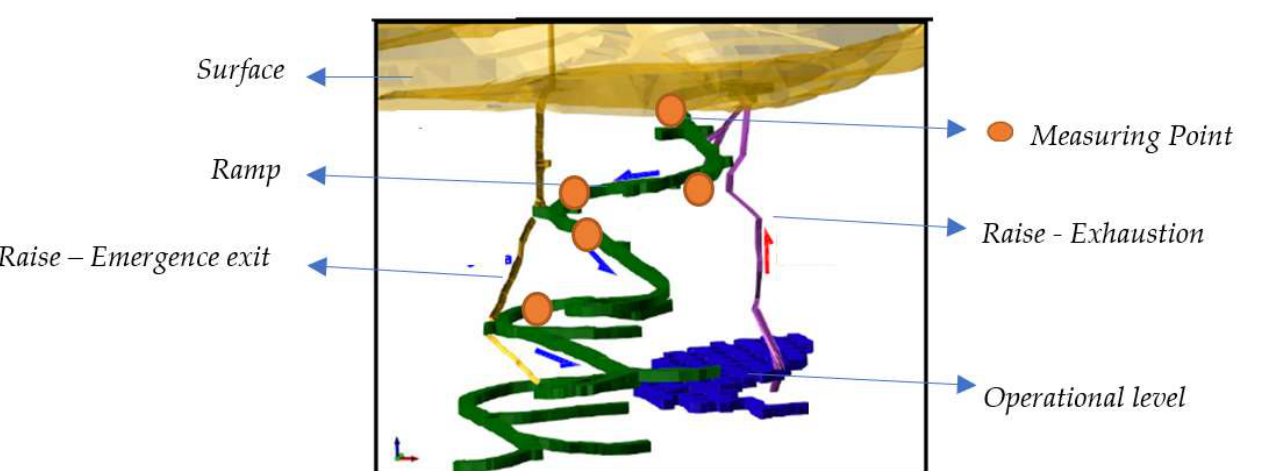
Figure 2. 3D underground mine map showing the monitoring points.